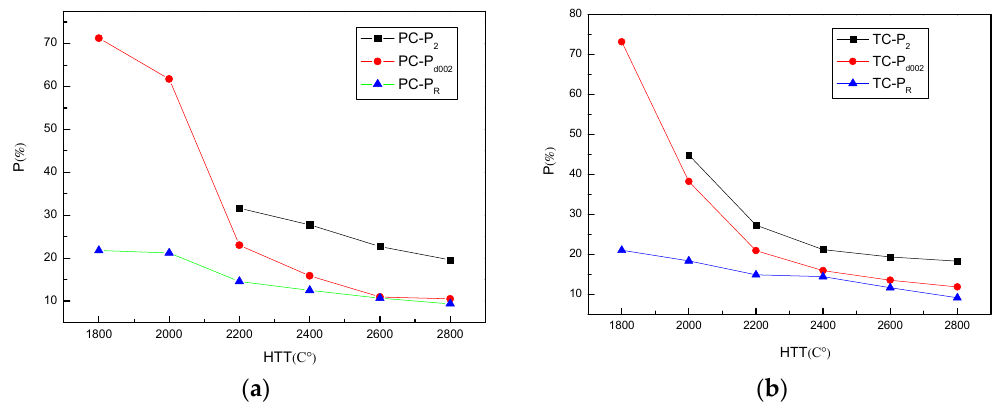
Figure 6. The relationship between the degree of disorder results of three methods and the heat treatment temperature graph. ( a ) The relationship between disordering degree of petroleum coke and heat treatment temperature; ( b ) The relationship between disordering degree of pitch coke and heat treatment temperature.